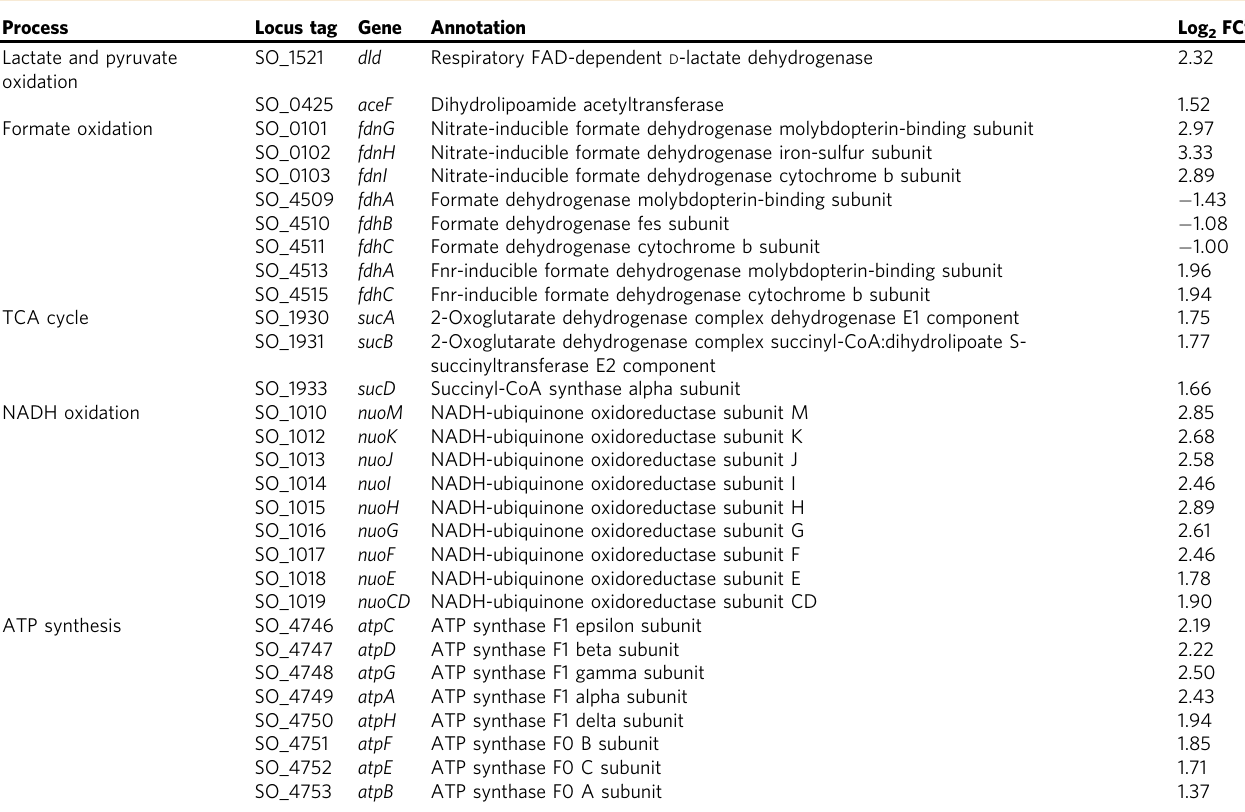
Table 1 List of selected electrode potential-responsive genes discussed in this study Process Locus tag